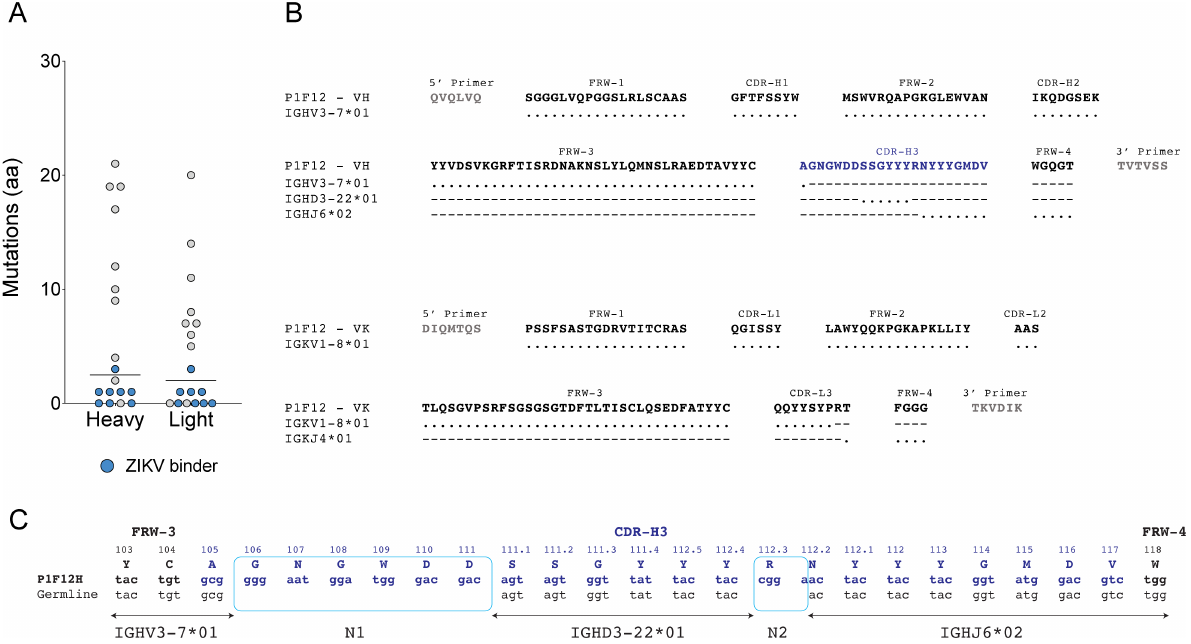
Fig 3. Plasmablast-derived ZIKV-specific mAbs had low SHM levels. A) Number of amino acid mutations from heavy and light chain germline sequences.B) Amino acid alignmentof P1F12 to germlinegenesshows no mutations downstreamof cloningprimer. Dots “.” indicatesequenceidentity to the germlinegene (shown in each row). Dashes “-” indicate that the Ab does not align to the annotated germline gene sequenceon that position.The CDR-H3 sequenceis indicatedin blue. C) Nucleotidealignmentof P1F12 CDR-H3 junction to germline genes. Boxes indicatejunctionaldiversity betweenV and D (N1), and D and J (N2) gene segments. Framework(FWR) and complementarity-determiningregions (CDRs) boundariesare directly annotated on top of the Ab sequence.Antibody regions were determined using